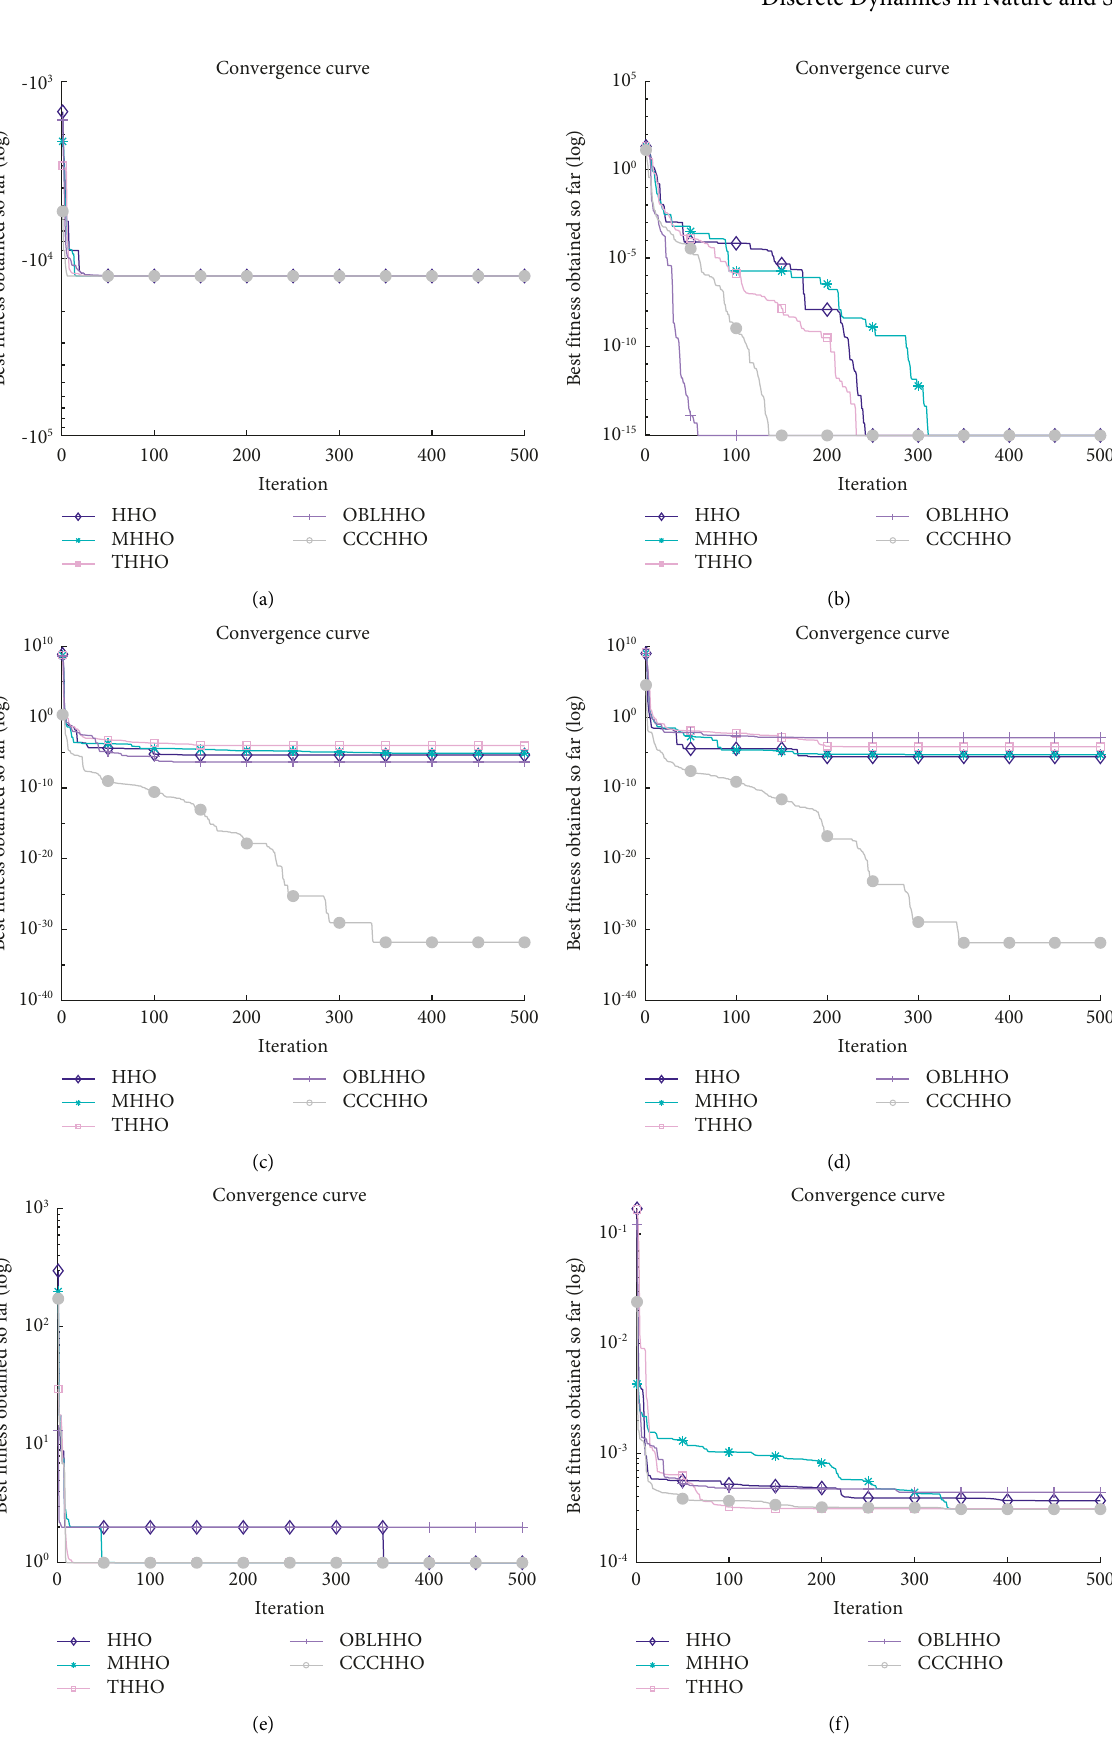
Figure 4: Convergence curve of multimodal function. (a) F6. (b) F7. (c) F8. (d) F9. (e) F10. (f)